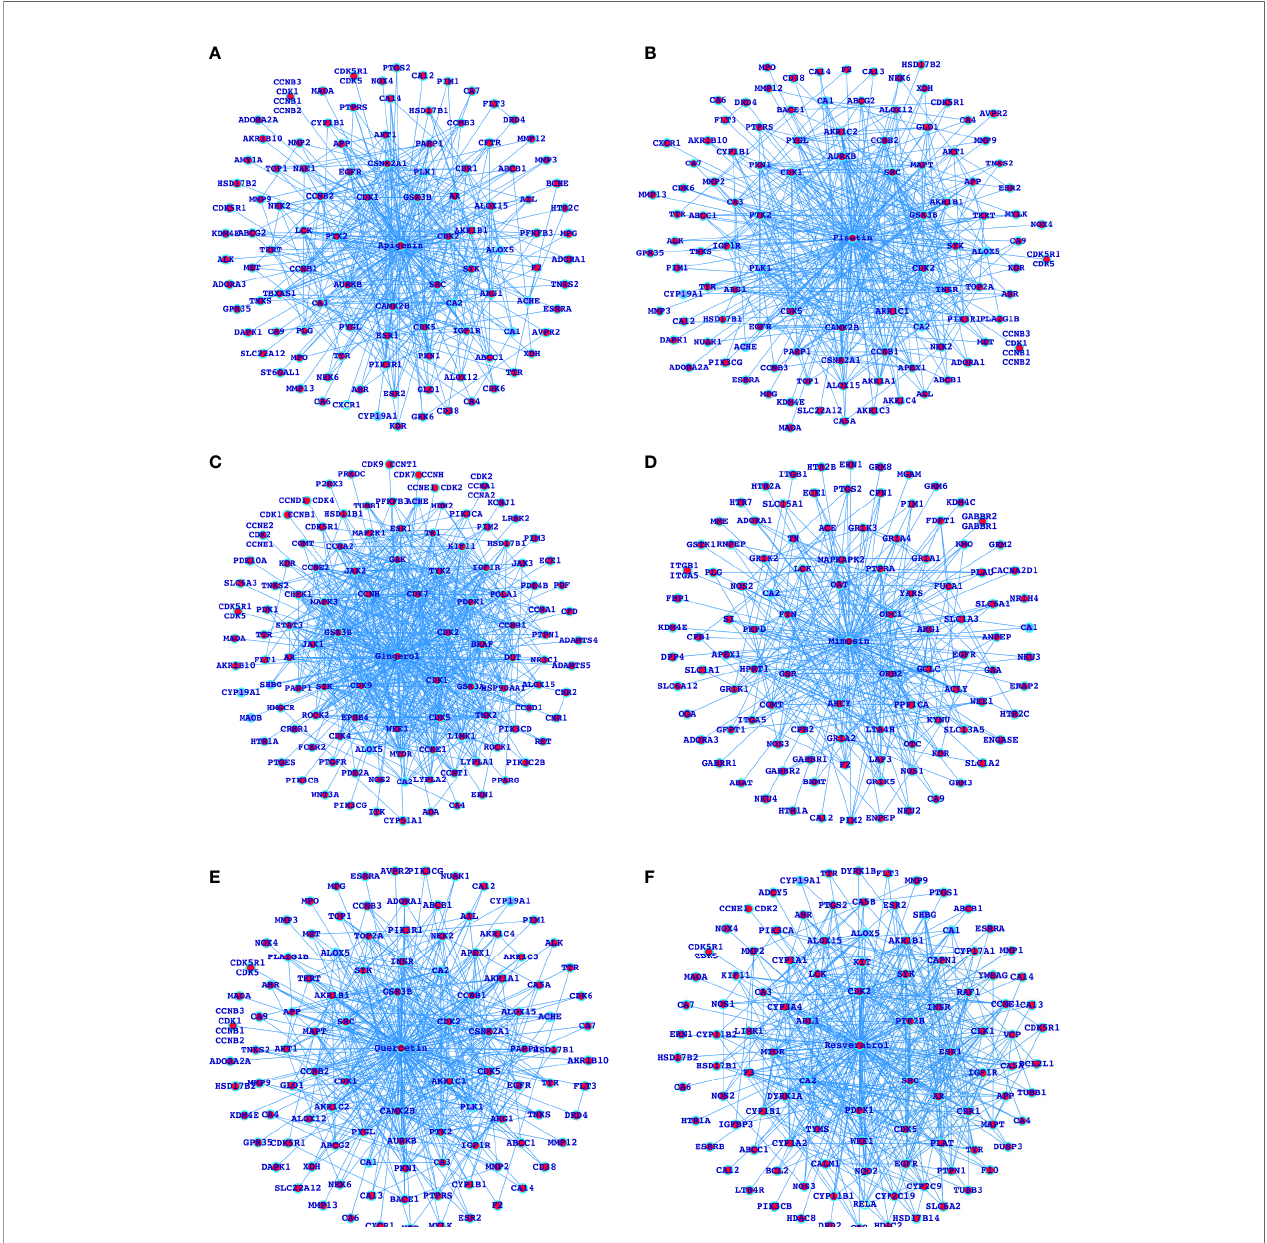
FIGURE 3 | Networks for the selected herbal drugs and their potential proteins interacting with the respective drugs (A – F)